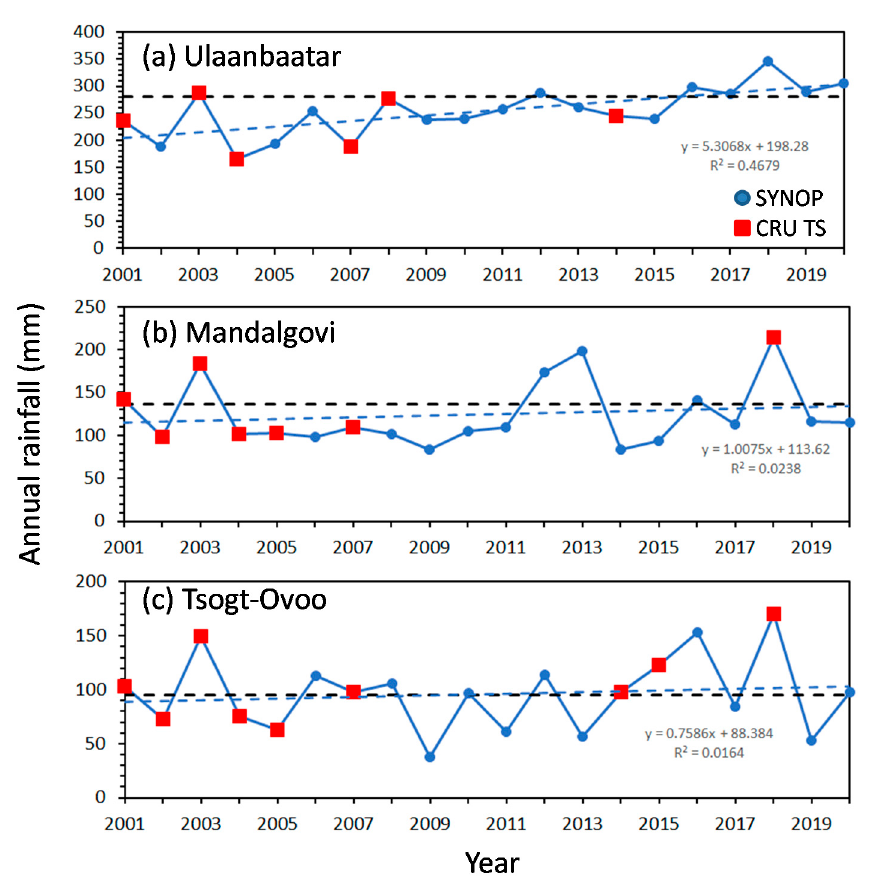
Figure 8. Annual changes (2001–2020) of annual rainfall in ( a ) Ulaanbaatar, ( b ) Mandalgovi, and ( c ) Tsogt-Ovoo. Black and blue dashed lines represent the normal values and trends during 1981–2010.